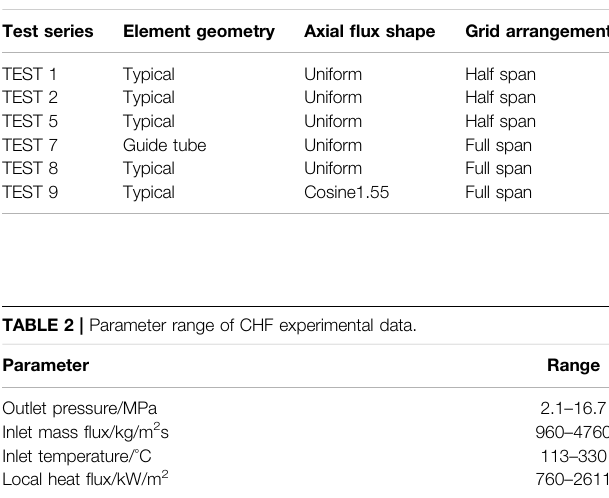
TABLE 1 | CHF database and characteristics of each test.